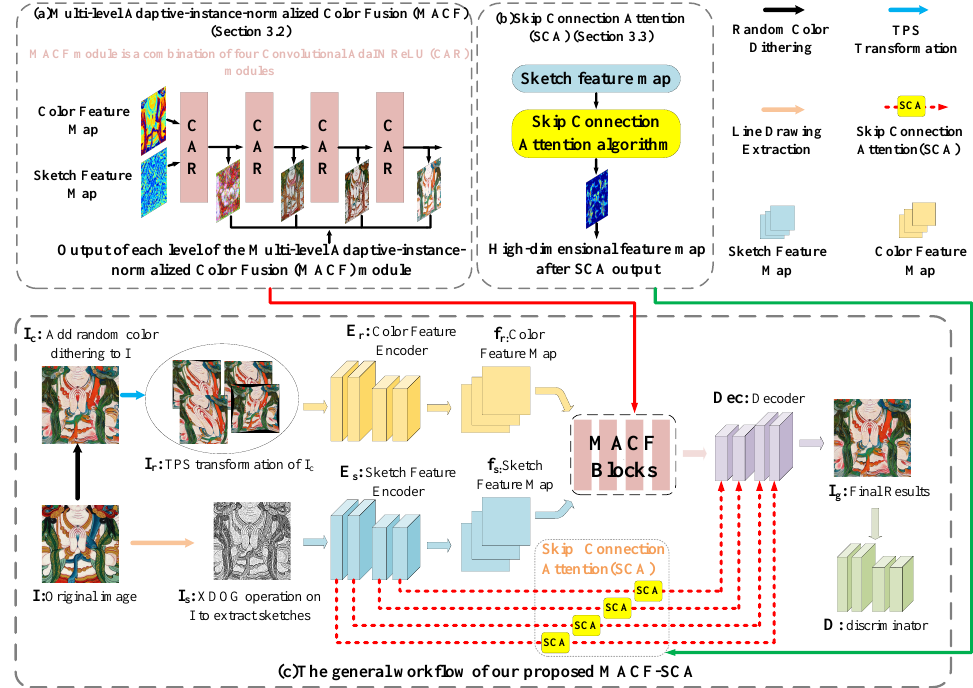
Figure 2. The proposed Thangka sketch colorization method consists of two parts: (1) a multi-level adaptive-instance-normalized color fusion (MACF) module for the fusion of color features and sketch features, and (2) the integration of a skip connection and attention (SCA) mechanism, which scales the extracted sketch features to capture a large enough receptive domain to distinguish the semantic information of the lines